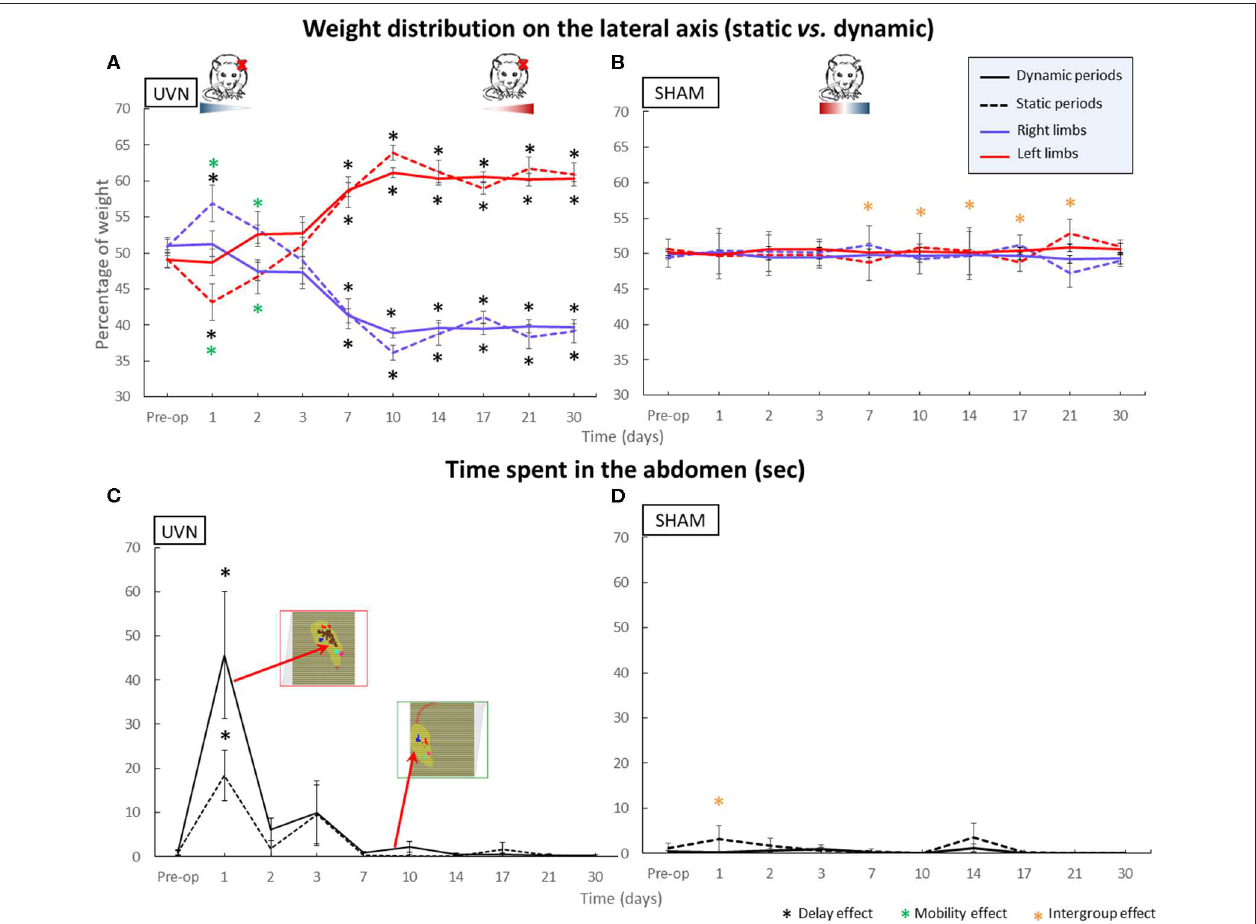
FIGURE 3 | Parameters discriminating between static and dynamic behavior. Within A. The weight distribution on the lateral axis and in B. the time spent on the abdomen. (A) The weight distribution on the lateral axis shows asymmetric kinetics in the UVN group. Rats correctly distribute their weight between right and left limbs during the preoperative session and then switch more weight to their right limbs in static condition at day 1 & day 2 post-UVN ( p < 0.05) while the dynamic weight distribution remains symmetrical. During the compensated period, UVN animals significantly distribute more weight on their left limbs whatever the static or dynamic condition. (B) SHAM animals always have a symmetrical weight distribution. The geometric shapes in color under the rat drawings indicate the amount of weight distribution on the left (red) and right (blue) paws in the UVN and SHAM group rats. (C) The UVN group spends significantly more time on their abdomen at day 1 postlesion compared to the preoperative session (0.0001 < p < 0.001) and compared to the SHAM group [static ( p < 0.005) and dynamic ( p < 0.0001)], with more time overall leaning on his abdomen in dynamic condition. (D) This behavior is never observed in the SHAM group. Standard errors of the mean are reported as vertical lines. Delay effect refers to significative differences with the preoperative condition; mobility effect means that a significative difference was found between static and dynamic condition; intergroup effect means that a significative difference was found between UVN and SHAM group (* p <